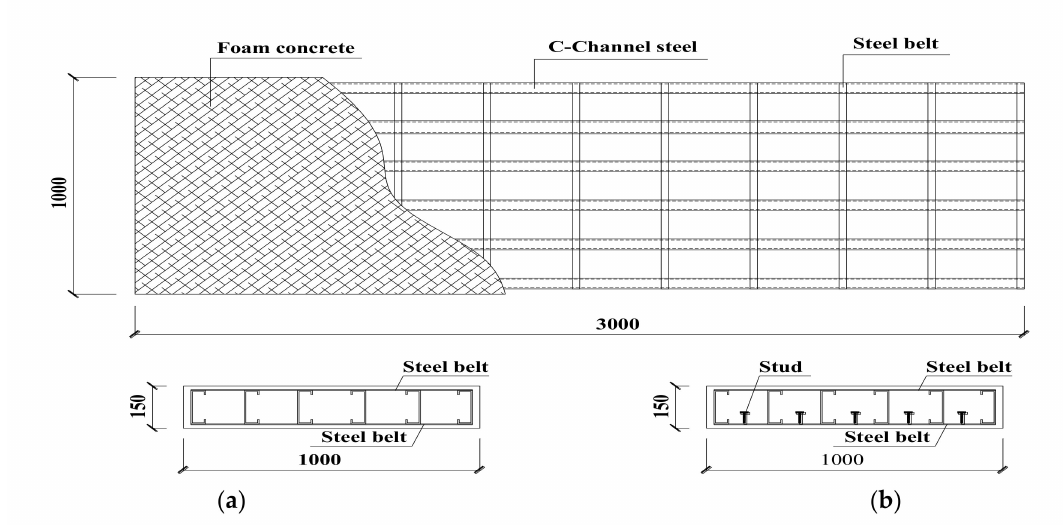
Figure 1. Foam concrete composite floor slabs with cold-formed thin-walled C steel channels embedment (mm). ( a ) Specimen B-1; ( b ) Specimen